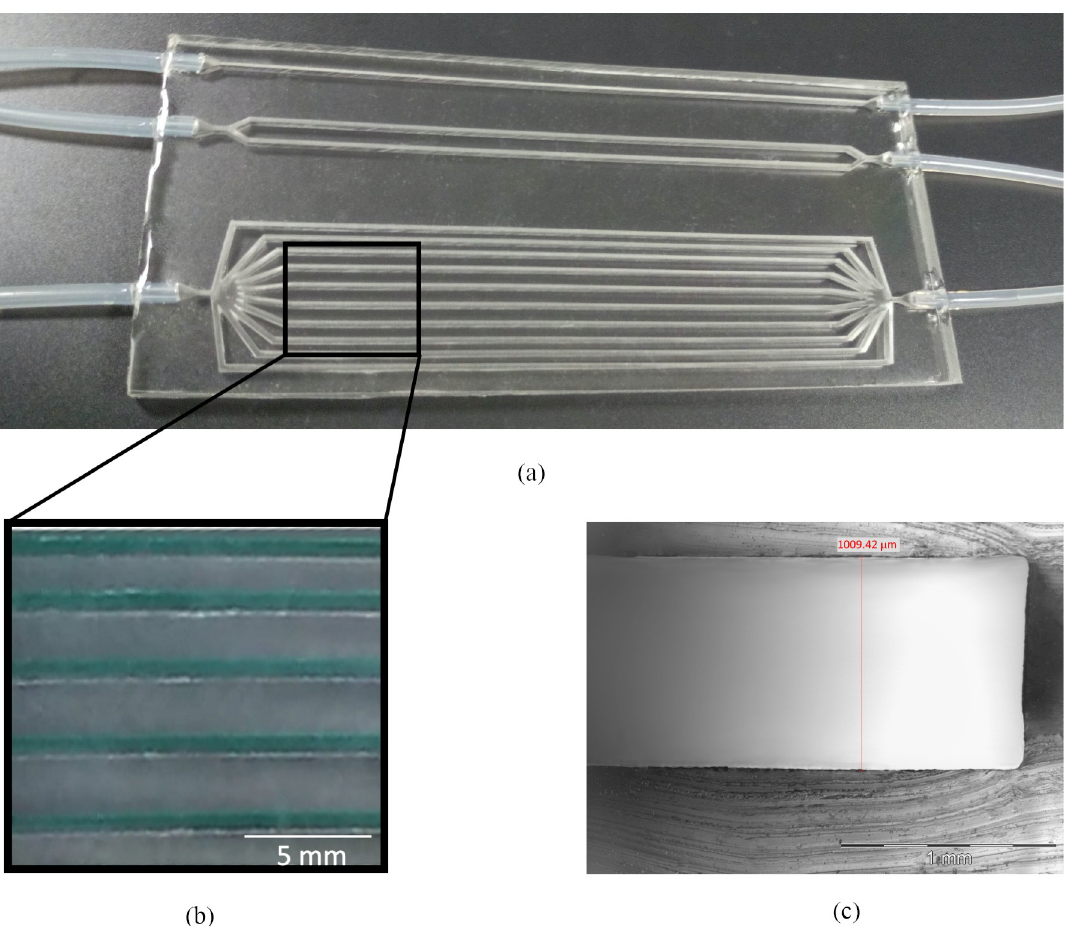
Fig 3. PDMS multi-channel device. Pictures showing (a) the 3D fluidic PDMS device with different ramifications of channels, inlets/ outlets are permanently connected to tubes, (b) the same channels filled with a blue dye to demonstrate absence of leakage and (c) the cross-section of a PDMS